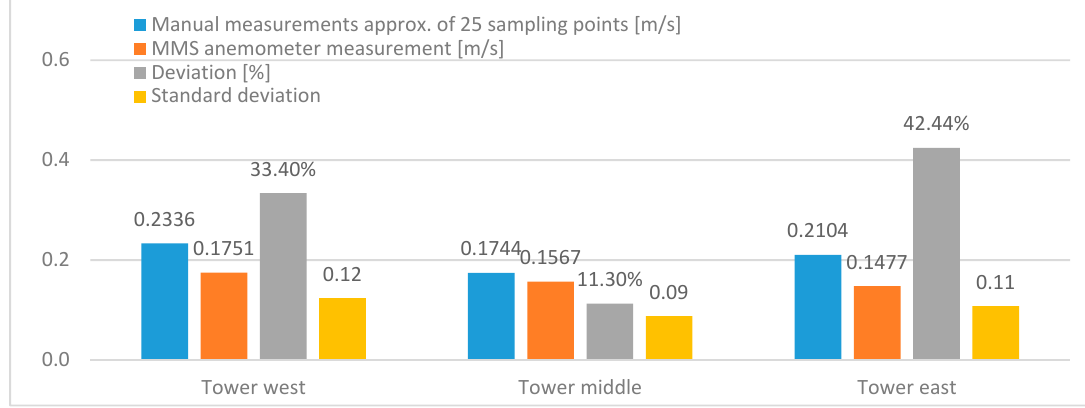
Figure 14. Comparison of hand measurement results in 25 sampling points per each tower (mean value) and MMS automated anemometer measurement of 1 sampling point about air velocity in the towers’ bottom inlets.